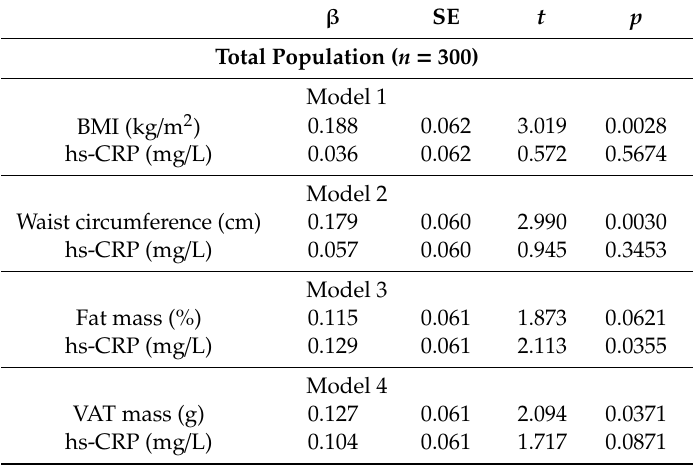
Table 5. Multivariate regression analysis assessing the relationship between serum lactoferrin concentrations (ng / mL) and selected